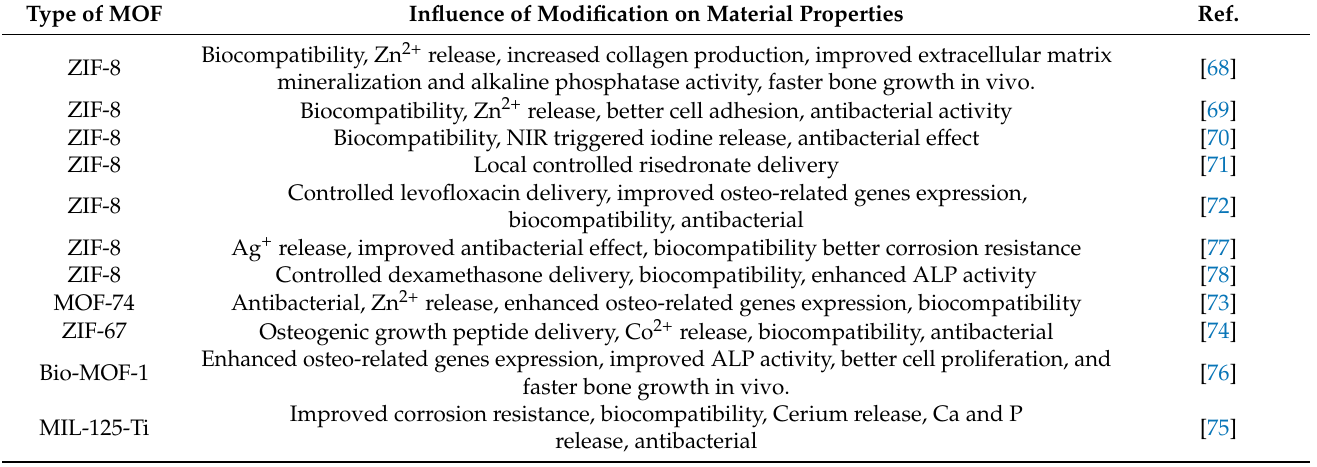
Table 1. The influence of MOF layers on the properties of titanium alloys is described so far in the